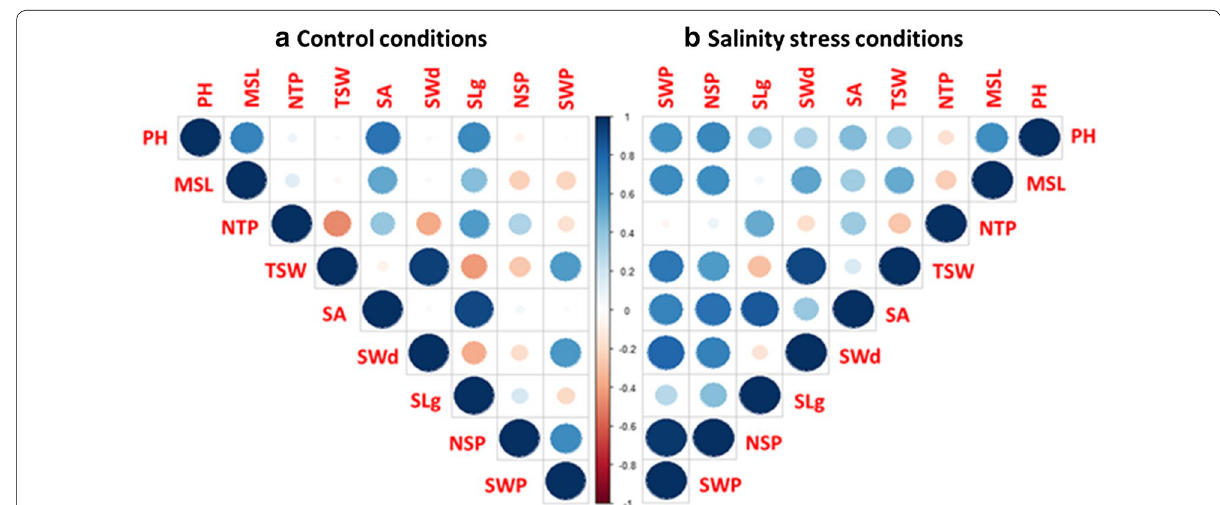
Fig. 6 Correlation matrix heatmap among the phenotypic and yield traits: PH plant height, MSL main spike length, NTP number of tillers/plant, TSW thousand seeds weight, SA seed area, SWd seed width, SLg seed length, NSP number of seeds/plant, SWP seeds weight/plant. Shades of blue indicate increasing positive correlation coefficient; shades of red indicate increasing negative correlation coefficient (color figure